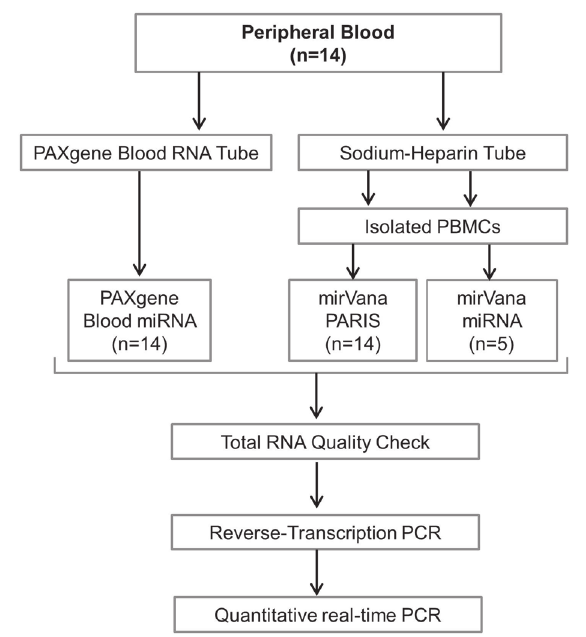
Figure 1. Experimental design . Peripheral blood was collected into various tubes as illustrated. Total RNA was extracted from whole blood using the PAXgene blood miRNA kit and from PBMCs using the mir Vana Paris and mir Vana isolation kits, respectively. The total RNA contained the miRNA population which was measured by firstly performing reverse transcription and then quantitative real-time